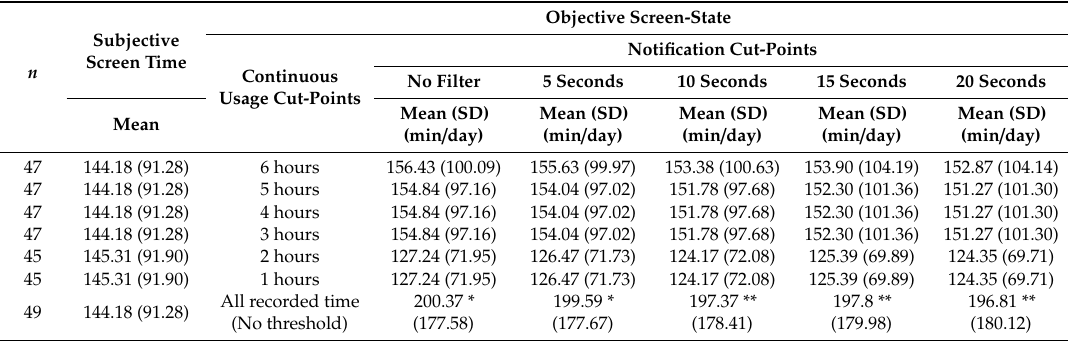
Table 3. Objective screen-state vs. subjective screen time on weekend days (minutes / day) ¥